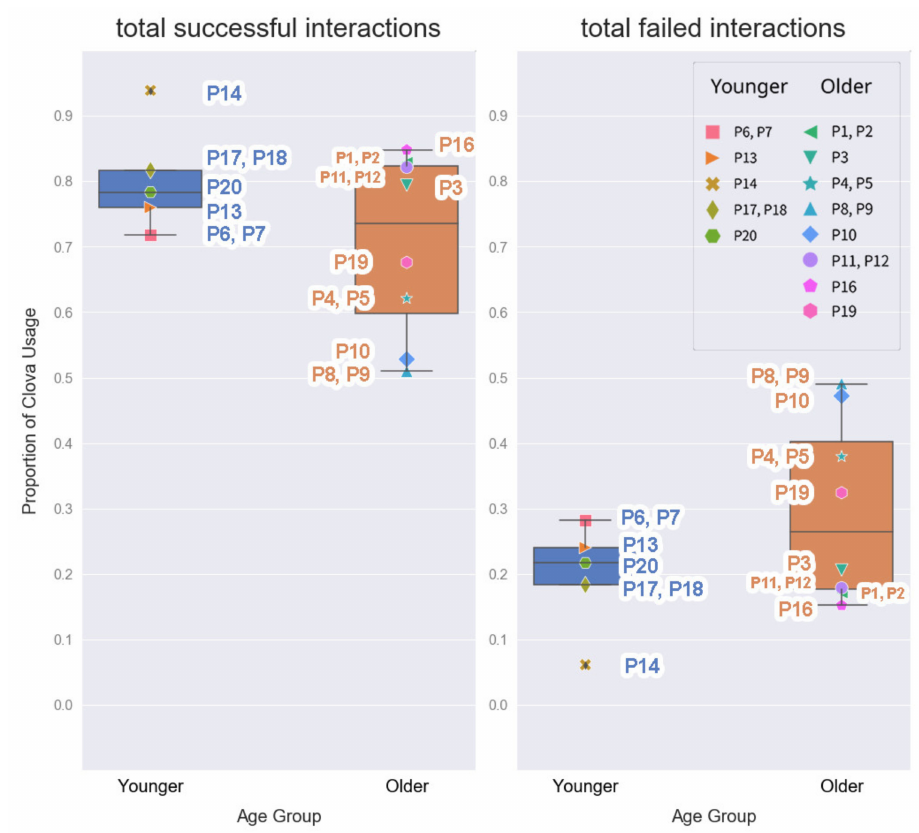
Figure 2. Proportion of Clova usage by age group: total successful interactions and total failed